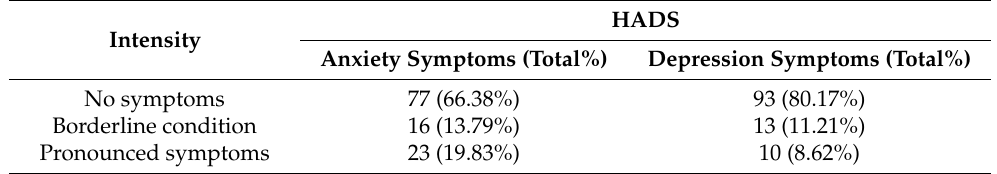
Table 3. Analysis of the prevalence of anxiety and depressive symptoms (HADS-M questionnaire).